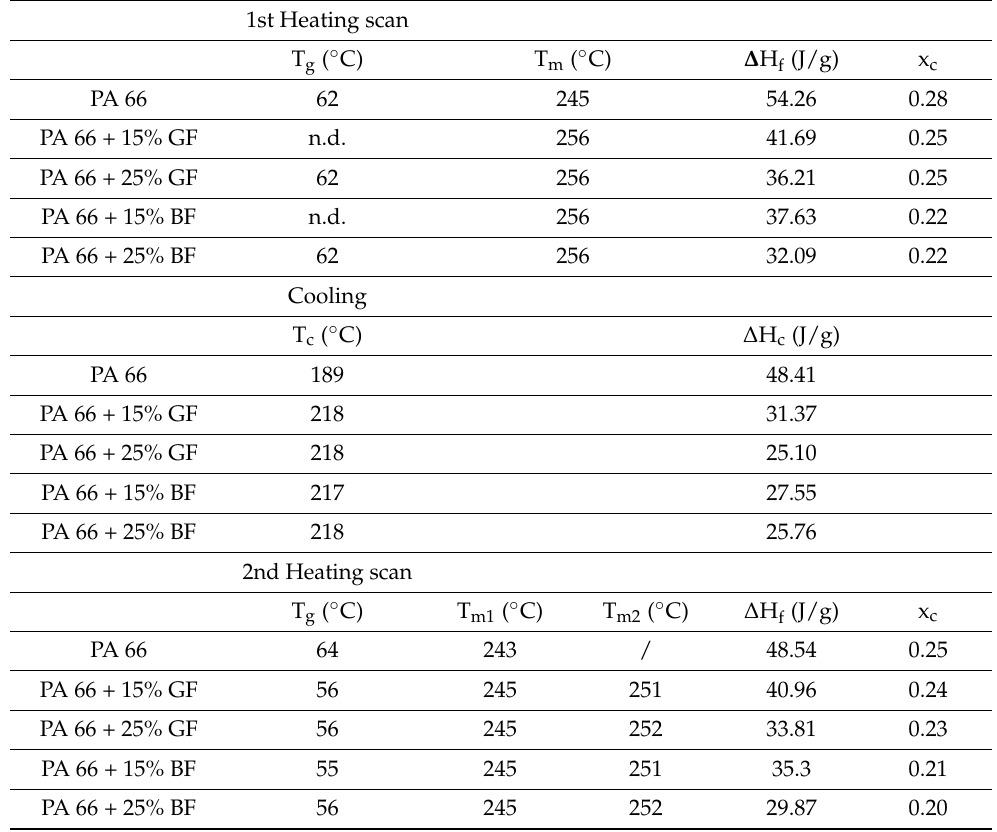
Table 3. Thermal properties of the composite materials as obtained by DSC